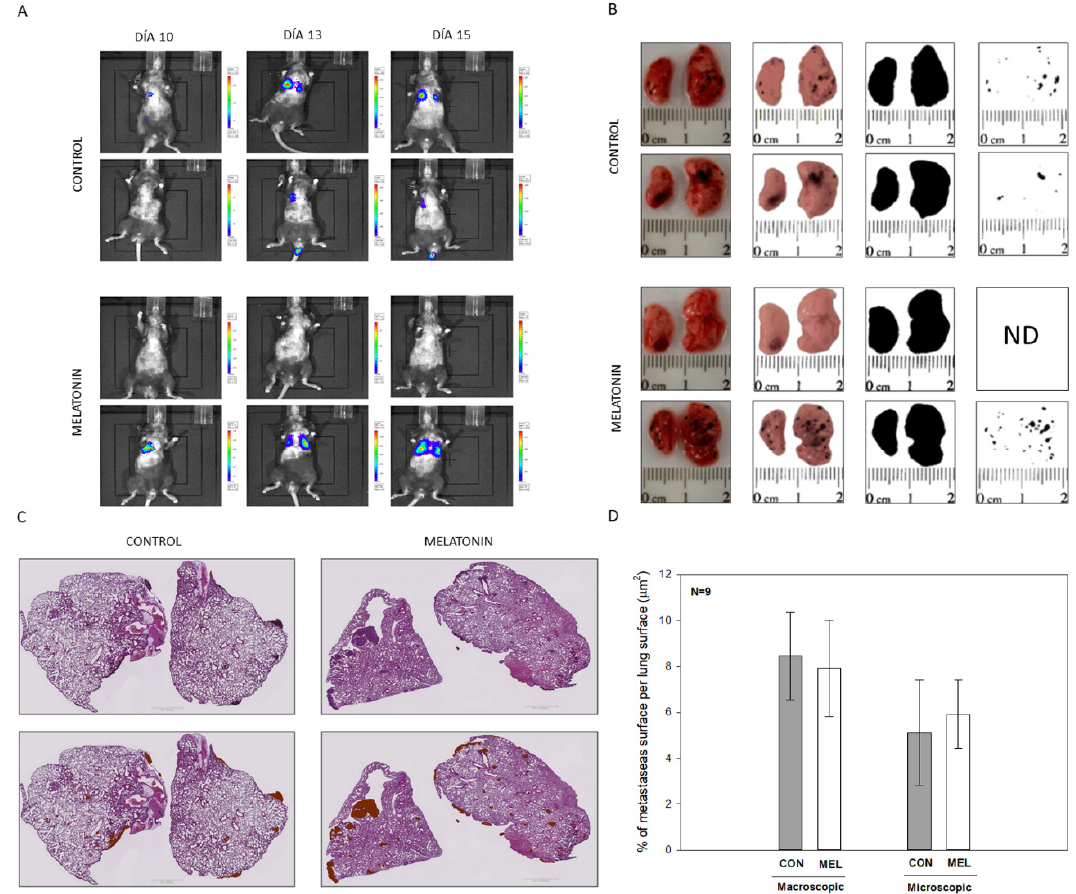
Figure 8. In vivo model for B16-10 lung metastasis treated with IP melatonin. ( A ) Bioluminescence localization and size of total lung metastases. ( B ) Macroscopic images of lung metastases and image isolation process. ( C ) Microscopic scanning of lung sections and detection of metastatic tissue. ( D ) Percentage of metastases Surface per total lung surface. Data were shown as average +/ − SEM. ND: not detectable.